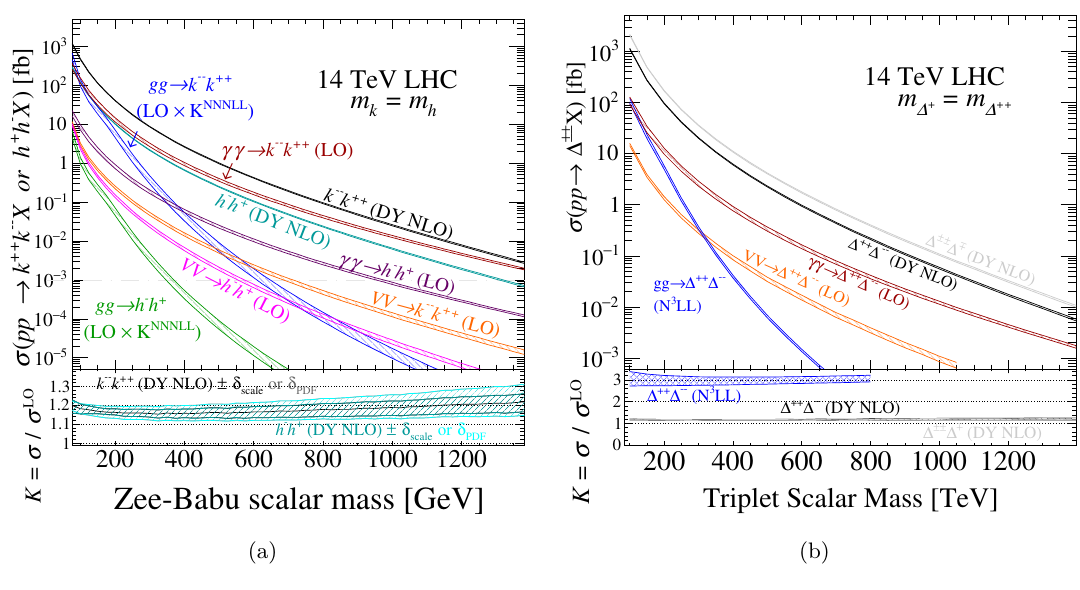
√ s = 14 TeV . (b) Analogous to (a) but for the production